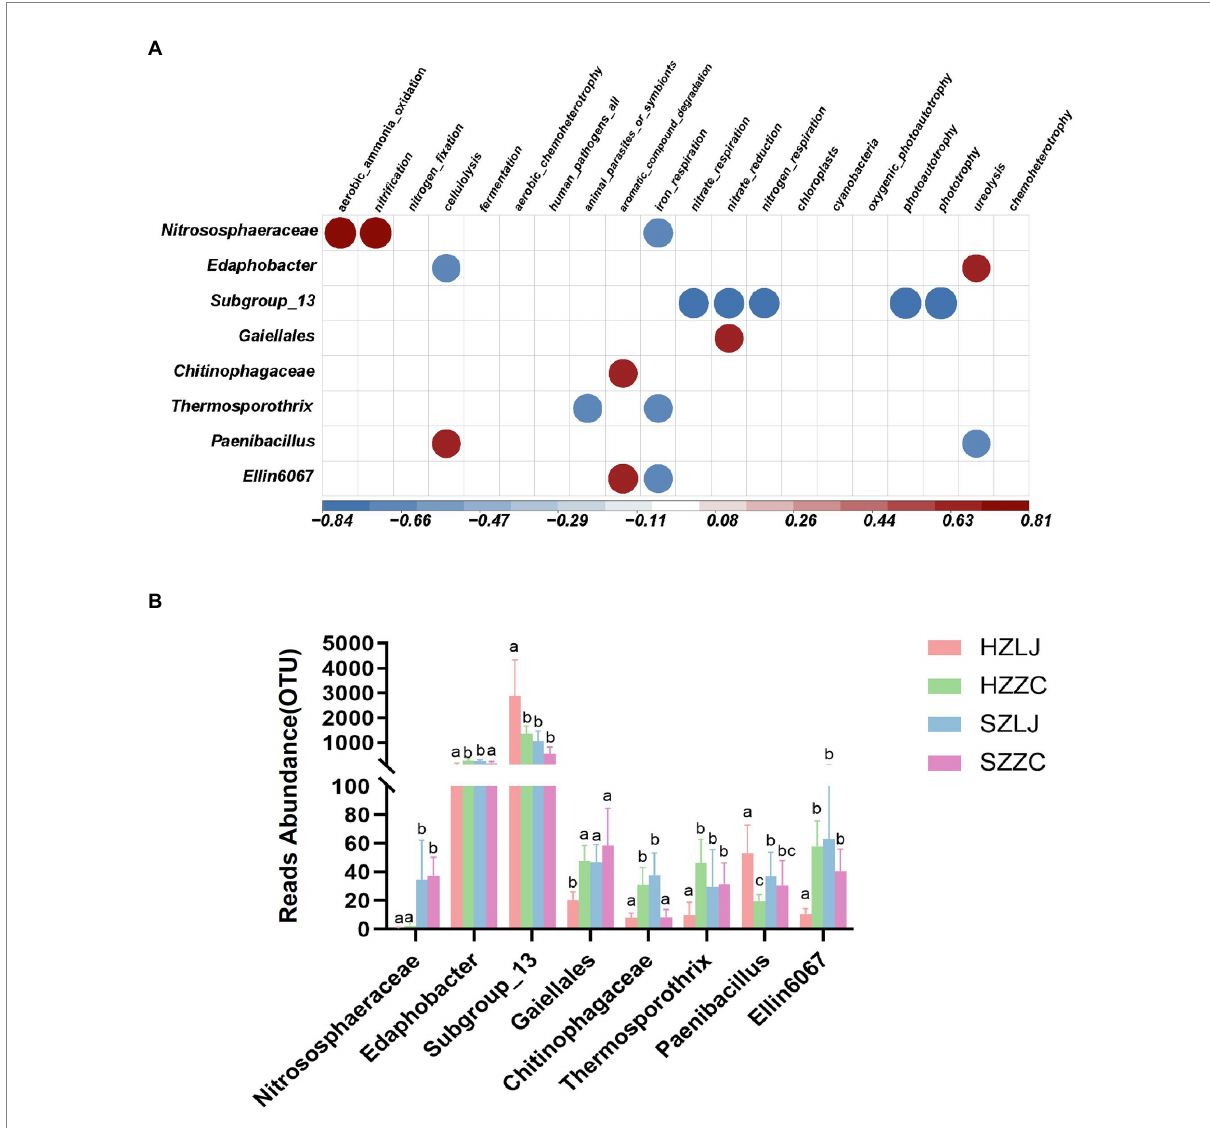
FIGURE 6 (A) Correlation heat map between bacterial OTUs and bacterial ecological function, Red was positively correlated, and blue was negatively correlated ( p < 0.05). (B) The OTU abundance of related bacteria in (A) . a, b and c represent significance at p <